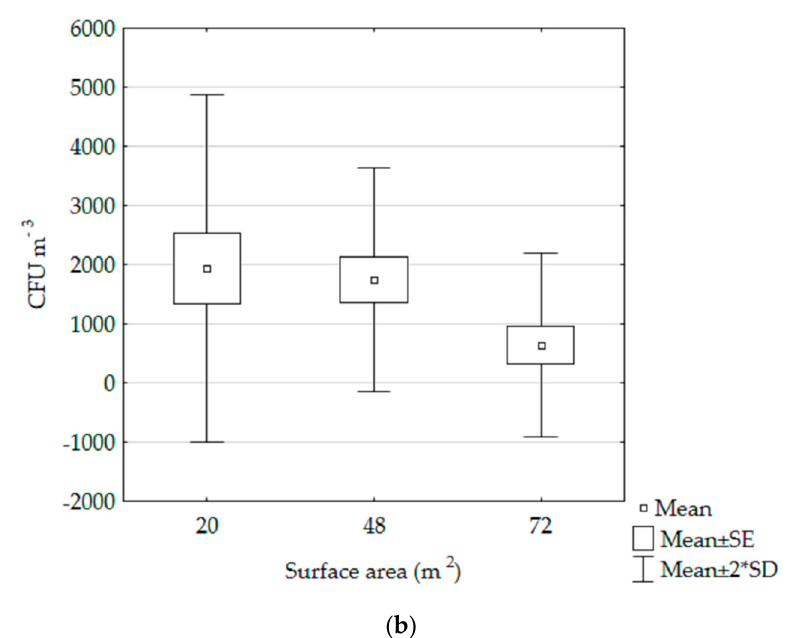
Figure 1. The relationship between ( a ) the size of the areas in School A and the total concentration of heterotrophic bacteria and ( b ) the size of the areas in School B and the total number of heterotrophic bacteria. SE—standard error; SD—standard deviation.